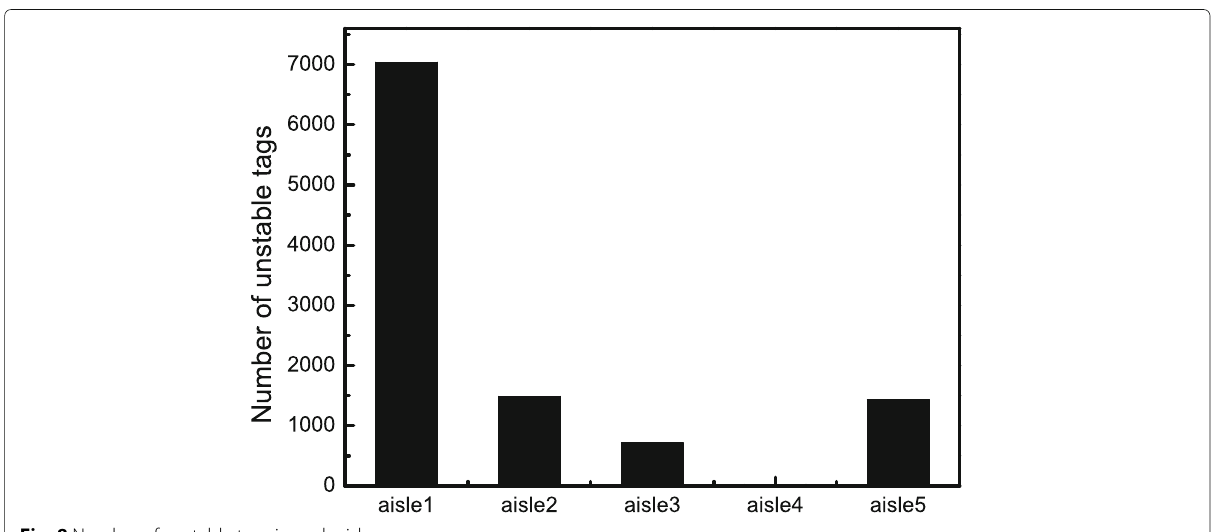
Fig. 8 Number of unstable tags in each aisle